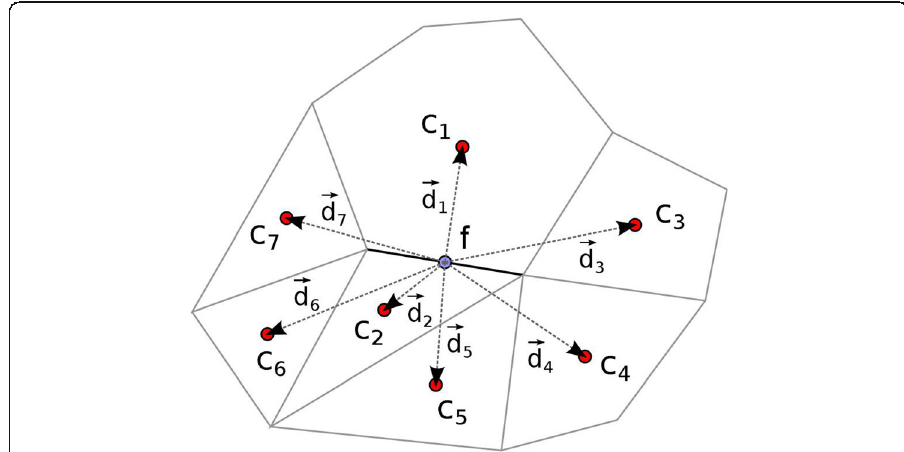
Fig. 16 Stencils for GG-IDW method and GG-LSQ method